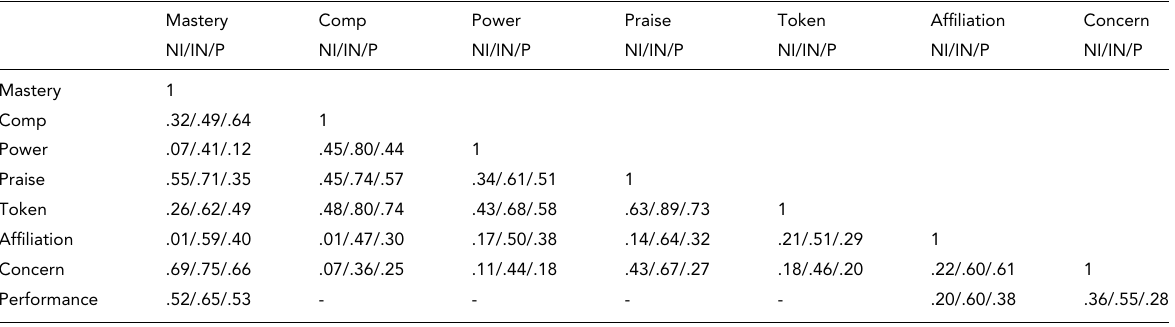
ISM Correlations for Non Indigenous, Indigenous and Papua New Guinean Samples